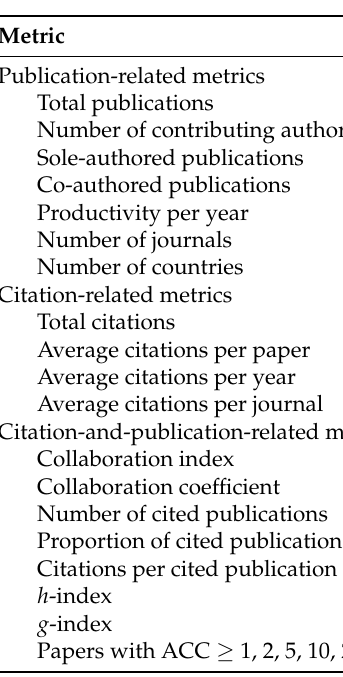
Table 1. Basic metrics for performance analysis.